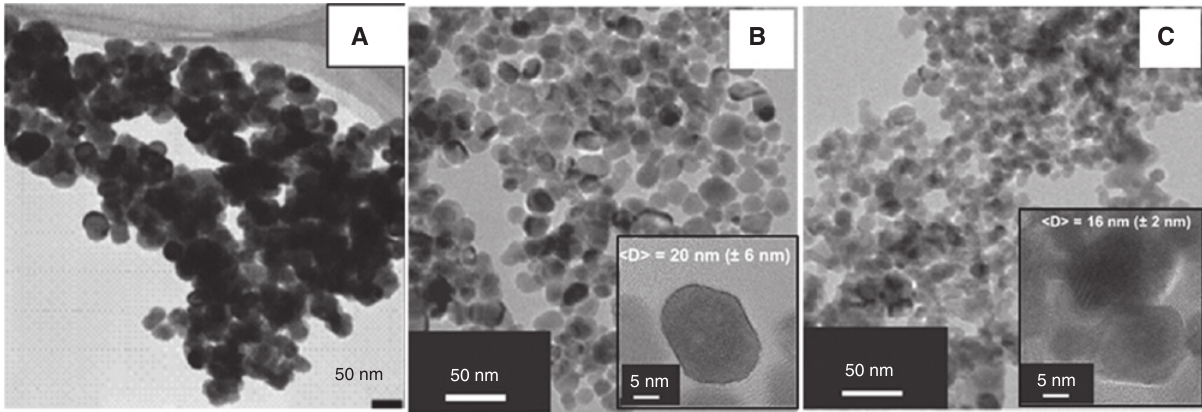
and Ba Sr TiO , 0 ≤ x ≤ 1, particles synthesized by two different supercritical chemical routes: (A) hydrothermal reac- Figure 16: BaTiO 3 1- x x 3 tion (BaTiO ) (reprinted with permission from Atashfaraza M, Shariatvy-Niassar M, Ohara S, Minami K, Umetsua M, Naka T, Adschri T, Fluid 3 Phase Equilibr. 2007, 257, 233–237 [87], Copyright 2007 Elsevier) and (B) sol-gel route in supercritical mixture (water + EtOH) for BaTiO (C) Ba Sr TiO NCs obtained through sol-gel routes in H O/EtOH mixtures. Reprinted with permission from Philippot G, Jensen KMO, 0.6 0.4 3 2 Christensen M, Elissalde C, Maglione M, Iversen BB, Aymonier C, J. Supercrit. Fluids 2014, 87, 111–117 [88], Copyright 2007